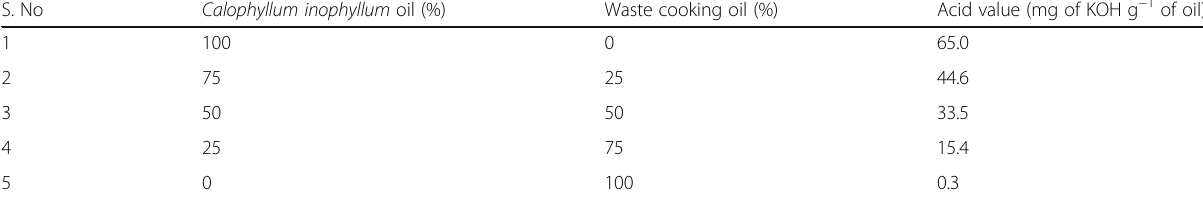
represent the quadratic effects of the independent parameters. Impact of calcined DDS concentration and methanol to Figure 6a presents the impact of DDS concentration and methanol to esterified CIO-WCO volumetric ratio on methyl ester production with time being fixed constant as 150 min. Increase in the conversion of oil to methyl esters was perceived with increased catalytic concentration and decreased with increased methanol to esterified CIO-WCO volumetric ratio. The higher amount of DDS enhanced the rate of re- action and hence higher reaction rate is achieved at a shorter reaction time [21]. At 8 wt% DDS and 62%